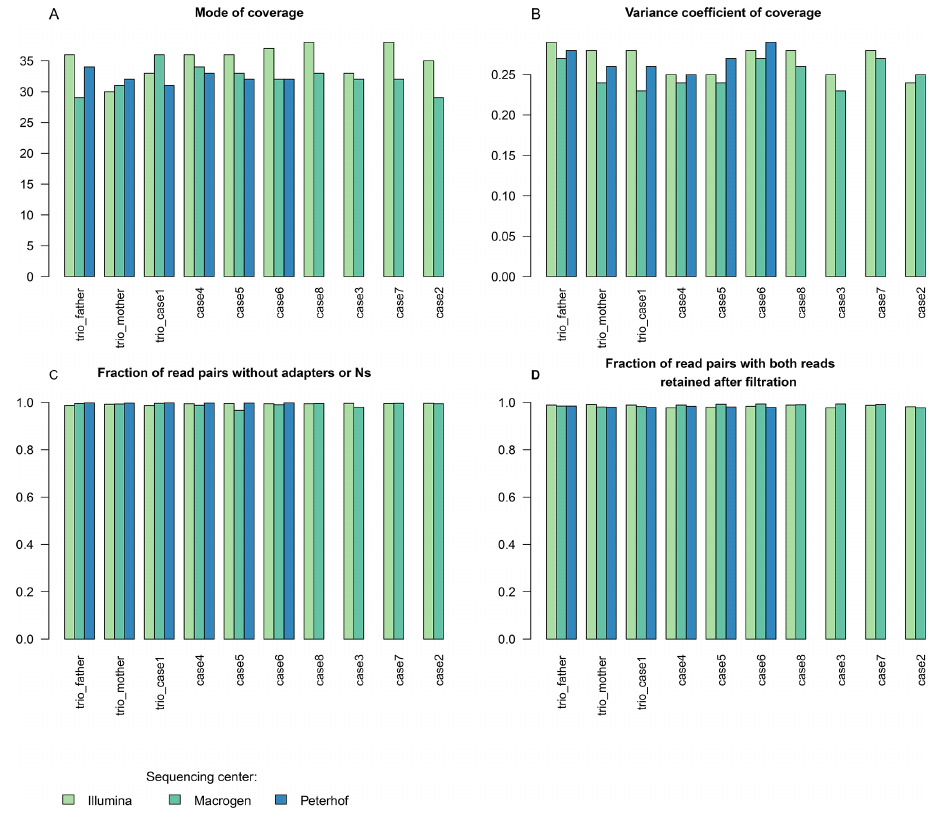
Fig 1. Raw read quality control parameters. Raw sequence read QC parameters are shown for three sequencing centers (colored differently).